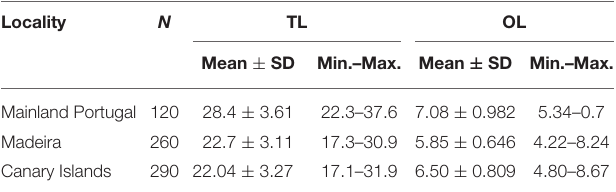
TABLE 1 | Number (N) of individuals and fish (TL, cm) and otolith (OL, mm) mean lengths ( ± standard deviation, SD) of Trachurus picturatus sampled off the north and central eastern Atlantic